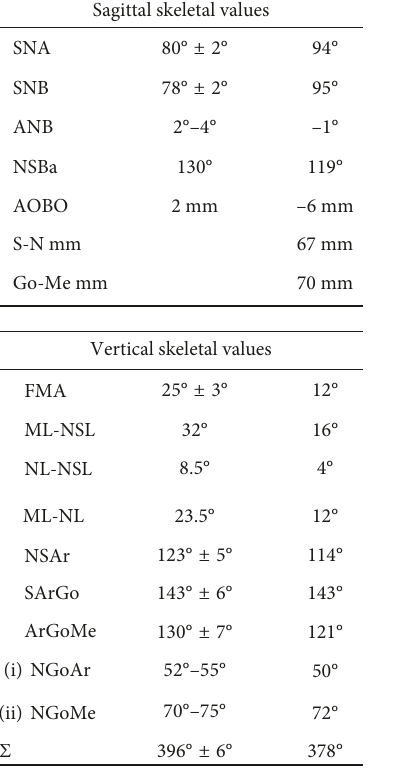
Figure 13: Cephalometric